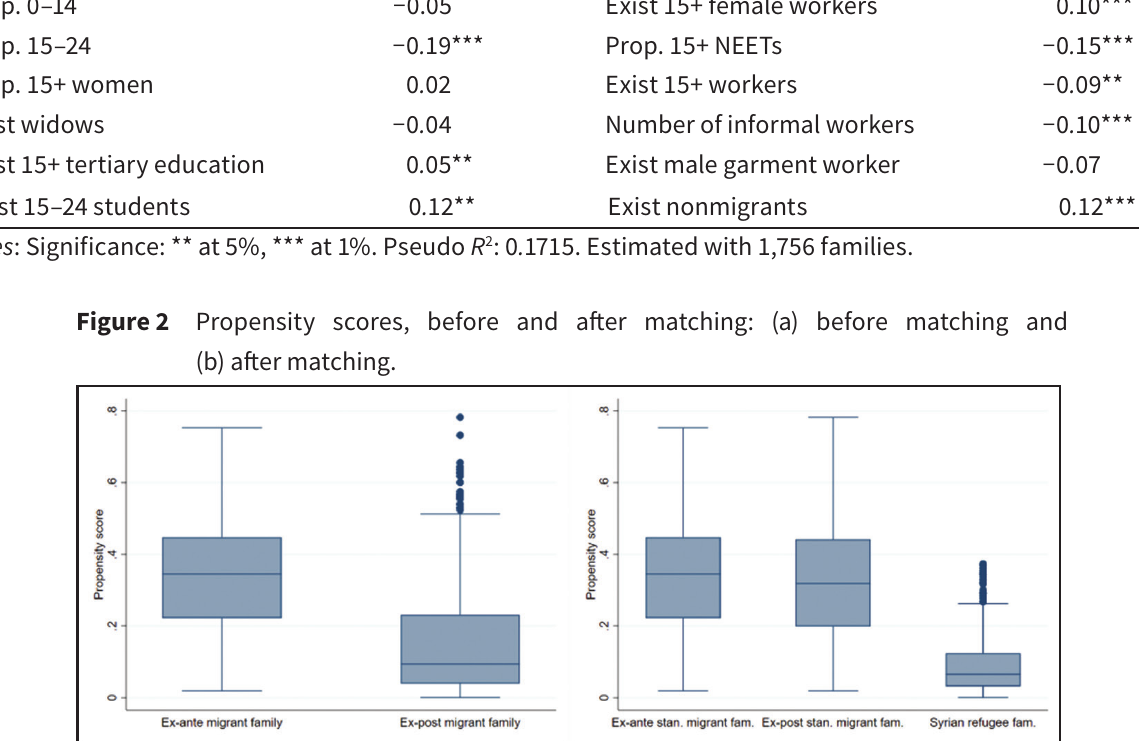
most Syrian refugees were initially registered in south eastern provinces of Turkey and hints refugees may have migrated to other regions.